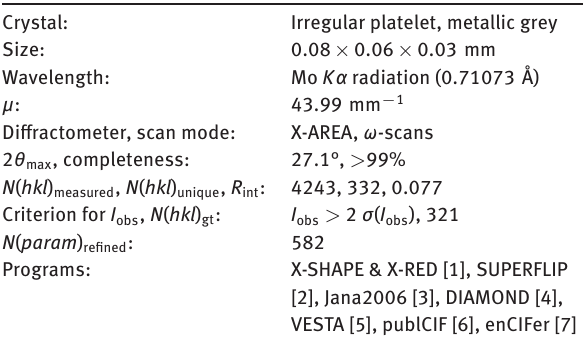
Table 1: Data collection and handling.